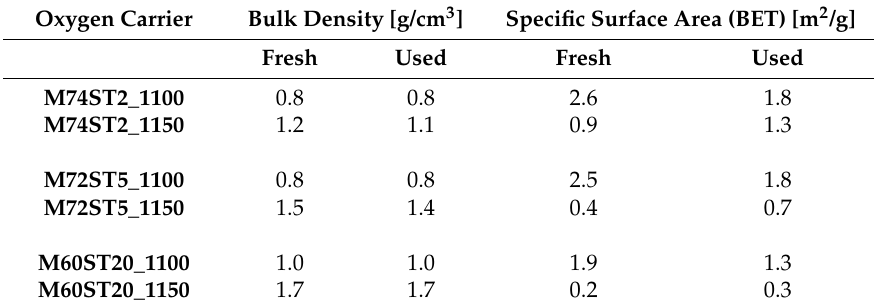
Table 3. Bulk density (tapped) and specific surface area (BET) for Mn-Si-Ti particles. Oxygen Carrier Bulk Density [g/cm 3